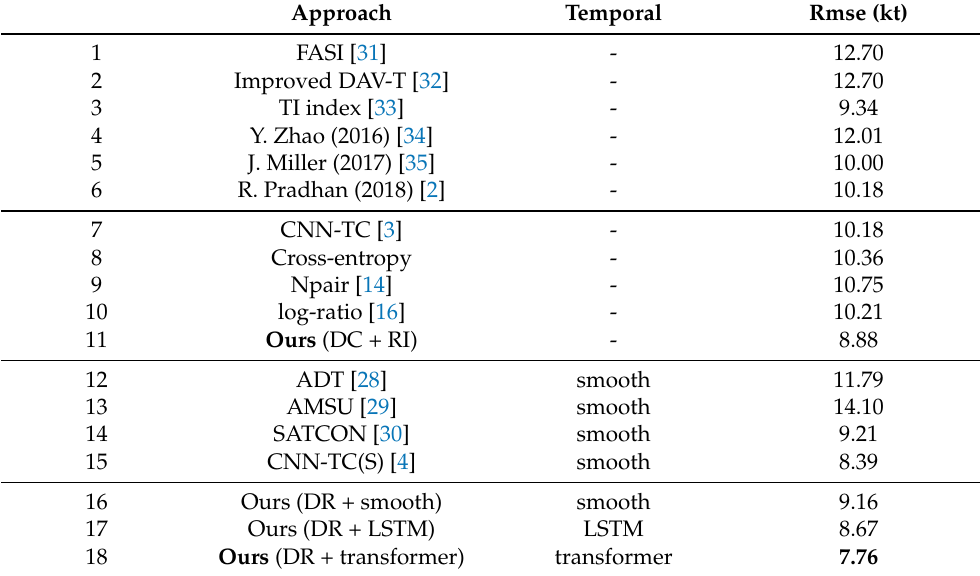
Table 1. Tropical cyclone estimation results compared with other methods. Bold numbers denote the best results. The second column represents the different ways we handled temporal